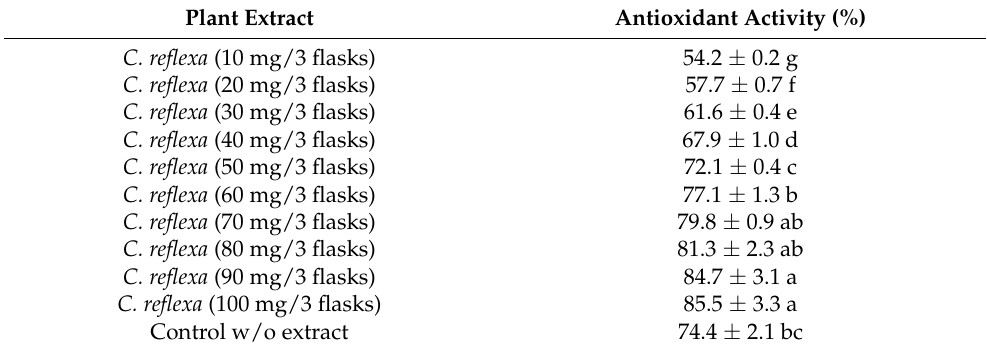
Table 4. The effect of different Cuscuta reflexa ( Cr ) extracts on antioxidant activity in adventitious roots of Stevia rebaudiana . Mean values were taken from triplicated experiment. The mean values along with SD ( ± ) with common alphabets was determined by Statistix v. 8.2 (USA) software. Plant